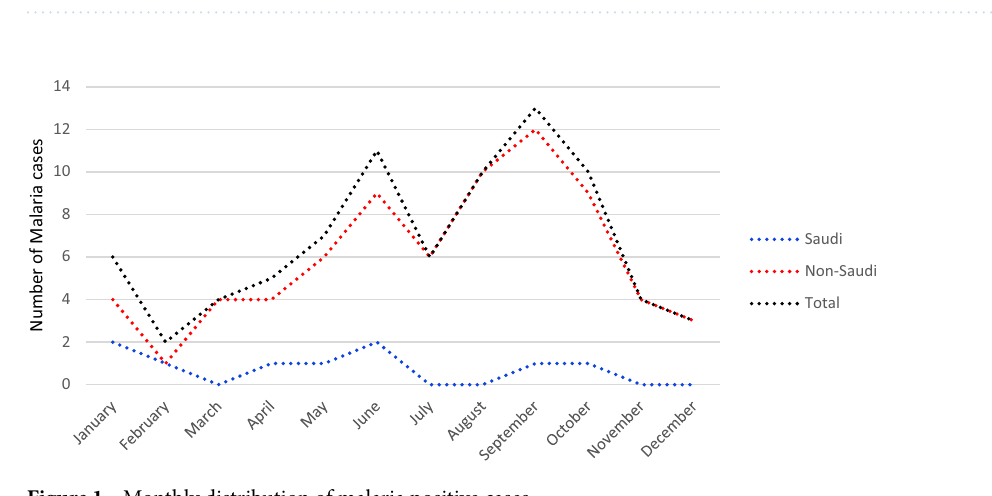
Figure 1. Monthly distribution of malaria positive cases.